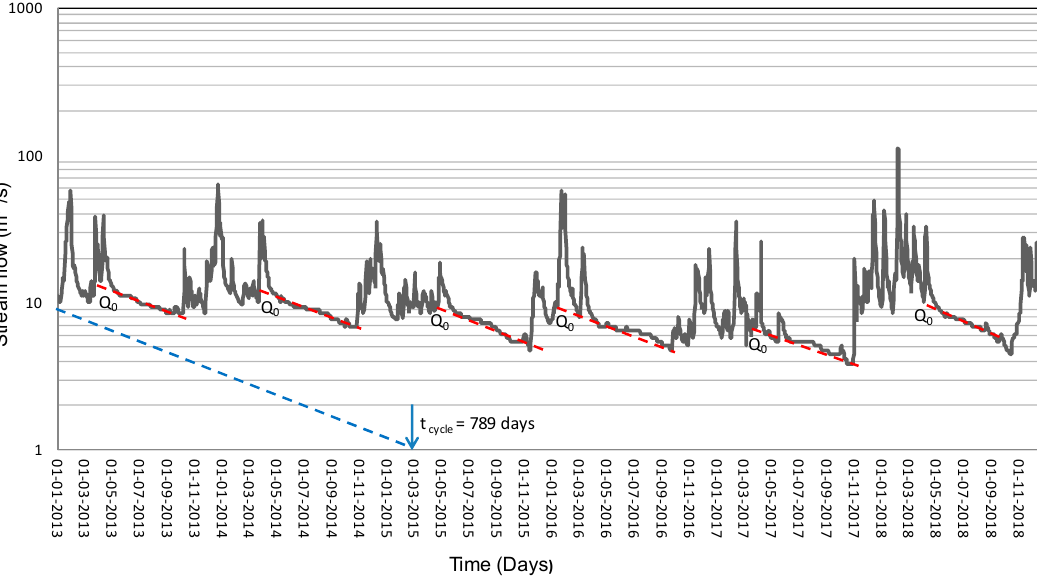
Figure 12. Hydrograph of Pandeiros River basin, state of Minas Gerais, Brazil, used to calculate the recession constant value.